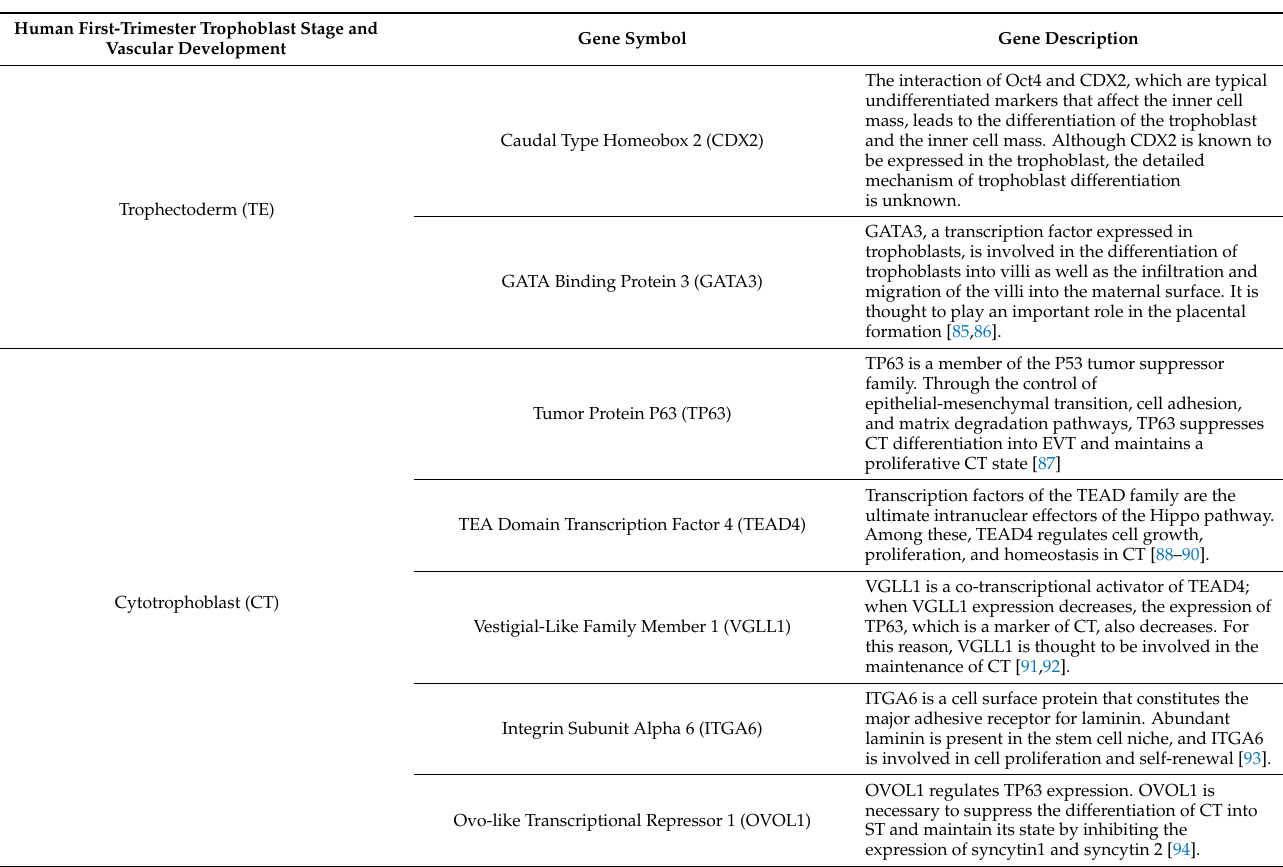
Figure 2. The fetomaternal interface. The major trophoblast subtypes and maternal cells are illustrated. Genes involved in the formation of the cytotrophoblast, syncytiotrophoblast, extravillous trophoblast, and angiogenesis are described. Table 1. Summary of each gene associated with placentation.